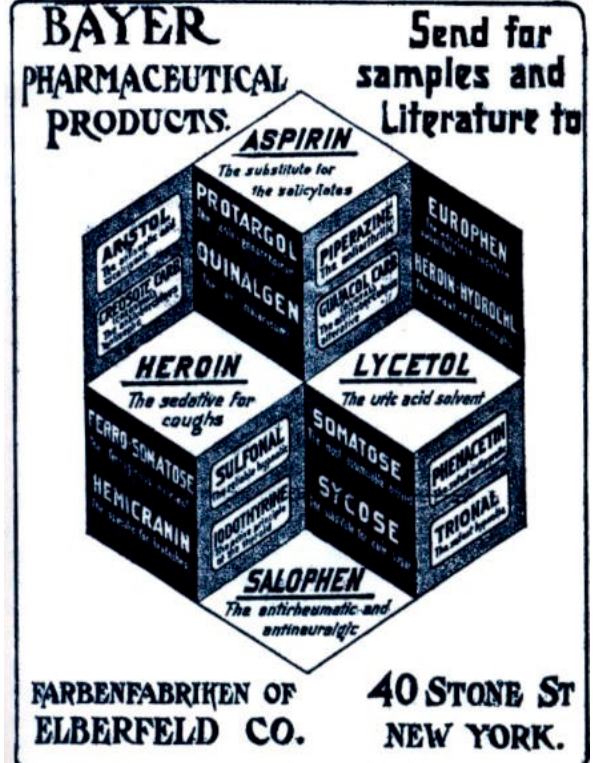
Figure 9. Advertisement for Bayer Heroin: the sedative for coughs.